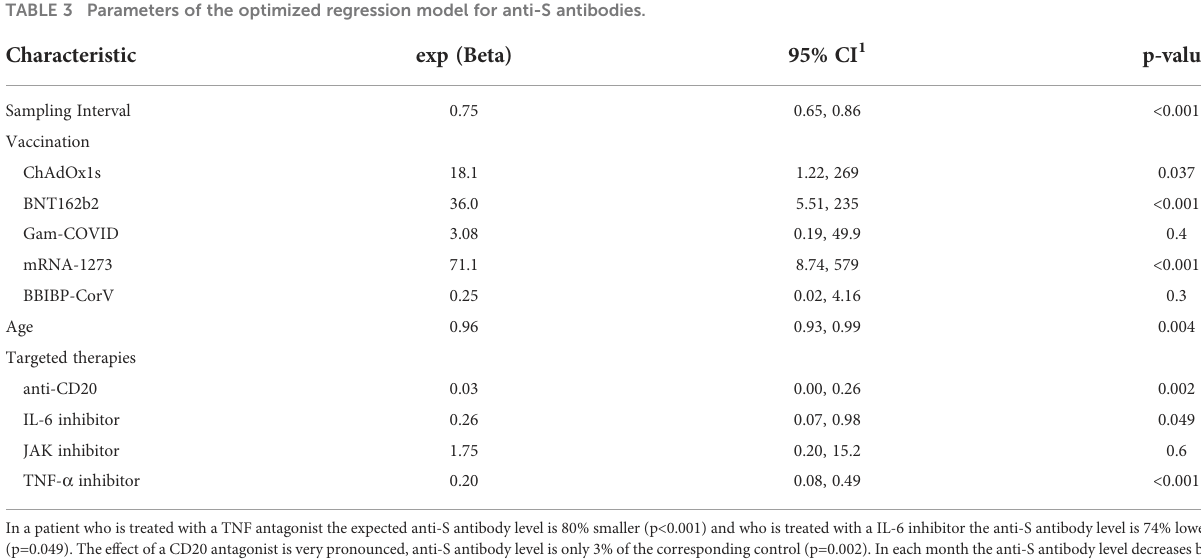
(Table 1 ). In the whole study population we found that the COVID-speci fi c T-cell mediated immune response was age dependent. Older patients had lower response; the estimated decrease was 2%/year (p<0.001) (Table 4). The initial immune response decreases gradually. The decrease is slower compared to anti-SARS-CoV-2 antibodies; it is 6% (p=0.044) in each